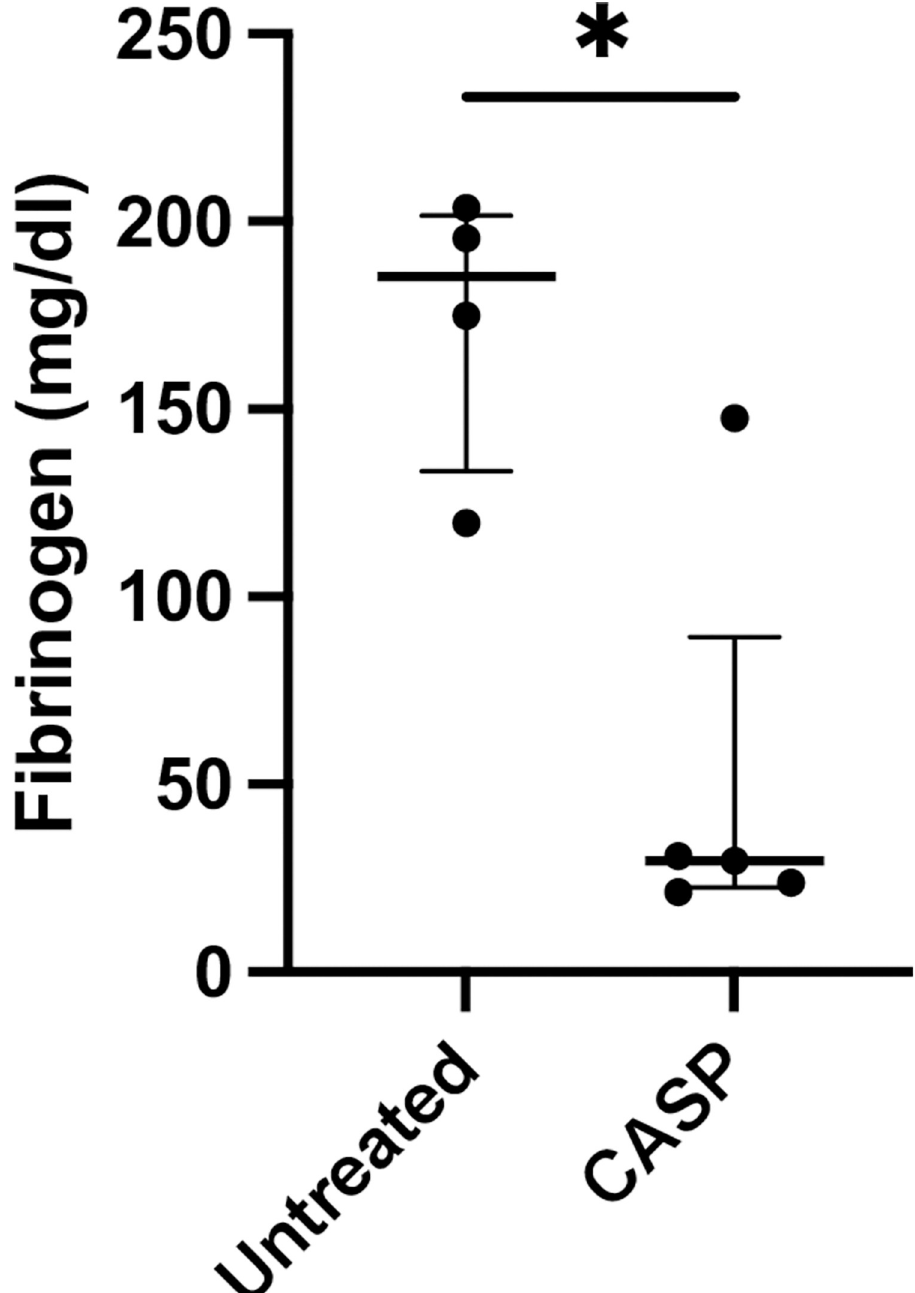
Fig 5. Fibrinogen blood levels 20 h after CASP surgery. Statistical results of fibrinogen blood levels 20 h after CASP surgery in 8- to 10-week-old C57BL/6 mice depicting a significant decrease in fibrinogen plasma levels in CASP- operated mice (CASP, black column). Control animals (untreated, white column) showed 185.2 (83.91 IQR) mg/dl vs. 29.71 (126.3 IQR) mg/dl blood levels 20 h after CASP surgery (p = 0.03 � ; n = 4 untreated group; n = 5 CASP group). The bold black line depicts the